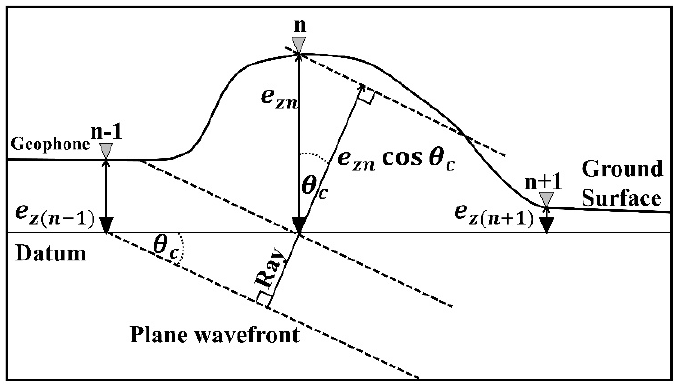
Figure 2. Illustration of errors in receiver elevations. Gray triangles indicate actual elevations of receivers, while black triangles indicate ideal elevations of receivers (after datum correction).